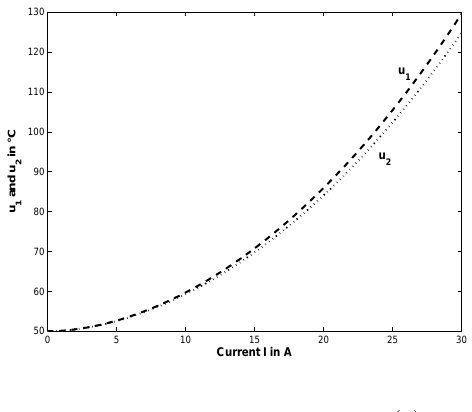
Figure 1. Iteration sequence G γ ( u ( n )